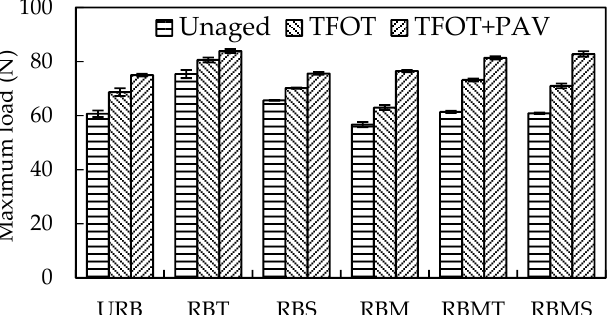
Figure 7. E ff ect of modification methods on the F max of rubberized Figure 7. Effect of modification methods on the F max of rubberized bitumen.